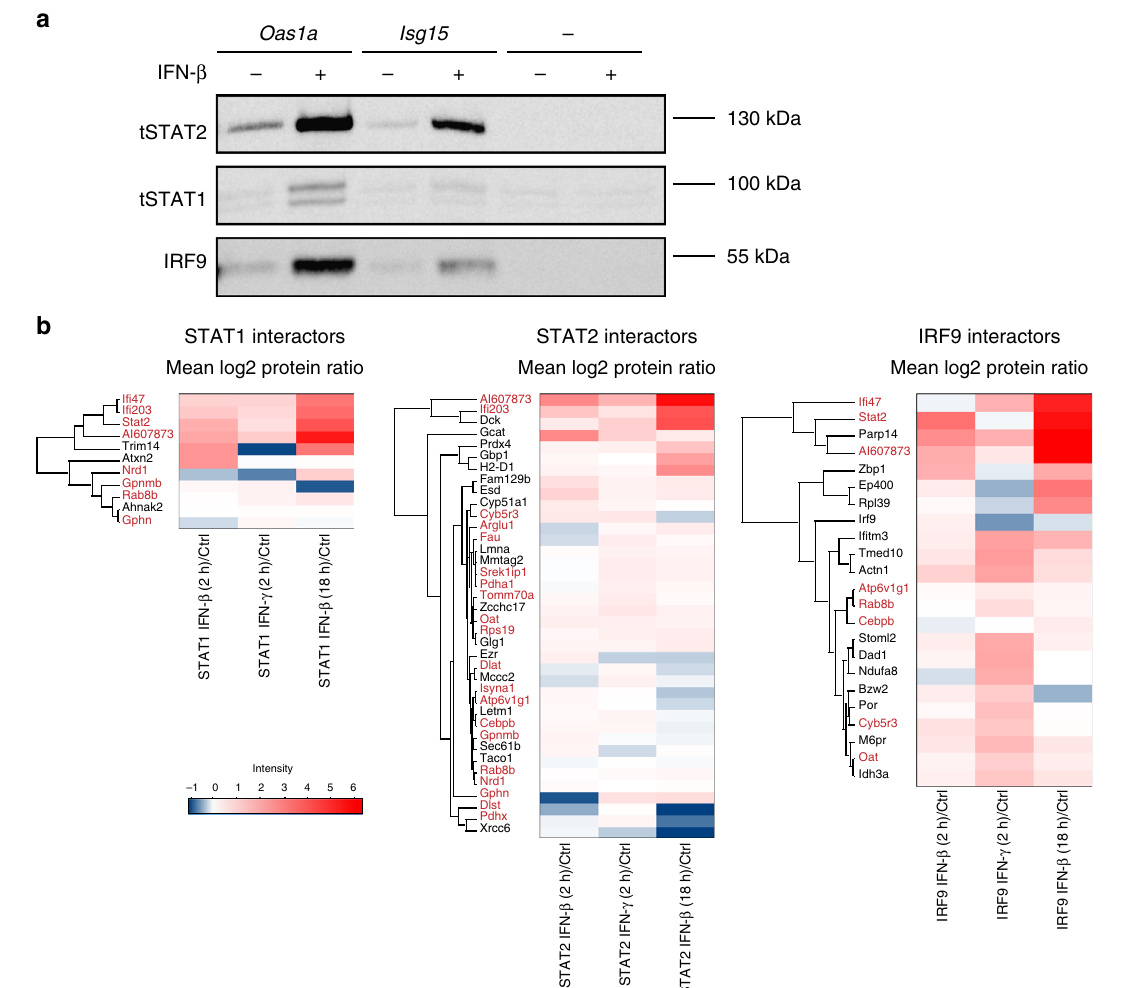
Fig. 5 Complex formation of ISGF3 subunits and proximity labeling of interactors. a Raw 264.7 cells were treated for 1.5 h with IFN- β . Cell lysates were incubated with a biotinylated Oas1a-ISRE oligo, a biotinylated Isg15-ISRE oligo, or plasmid DNA. DNA-bound protein complexes were isolated by streptavidin af fi nity puri fi cation, followed by western blot analysis. b STAT1, STAT2, and IRF9 interactome dynamics in response to interferon treatment. Hierarchical cluster analysis of proteins signi fi cantly enriched upon treatment with IFN- β or IFN- γ . Proteins were fi ltered, which were at least twofold enriched above background (myc-BirA* or BirA*-NLS controls) in at least one condition at an adjusted p -value of < 0.01, and which showed at least a twofold increase in intensity after interferon induction when compared with steady-state conditions. For this fi ltered set of proteins, we computed the mean log 2 LFQ protein ratio of the interferon-induced (2 and 18 h) and the steady-state condition and used these values to generate a hierarchical cluster analysis and heat maps in Perseus with default settings. Interactor names shown in red were found associated with more than one ISGF3 subunit across all experimental conditions, including interactors under resting conditions shown in Supplementary Data 7. Source data are provided as a source data fi